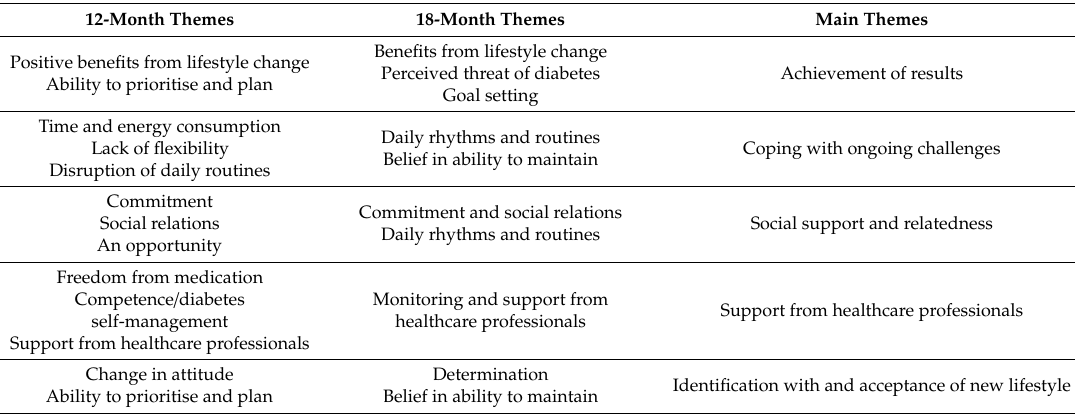
Table 5. Main themes and findings regarding informants’ motivation and barriers to adopting and maintaining lifestyle changes, based on interviews at 12 and 18